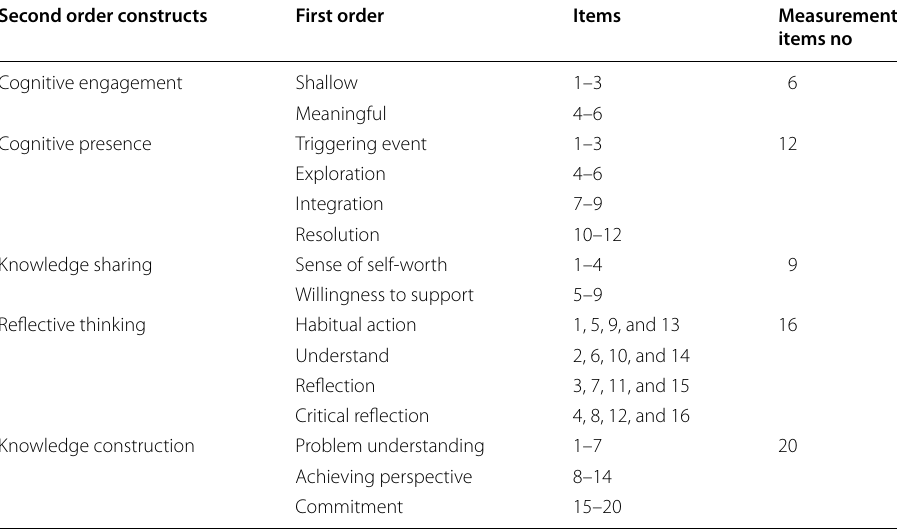
Table 2 Description of relational transaction practices and outcomes Second order constructs